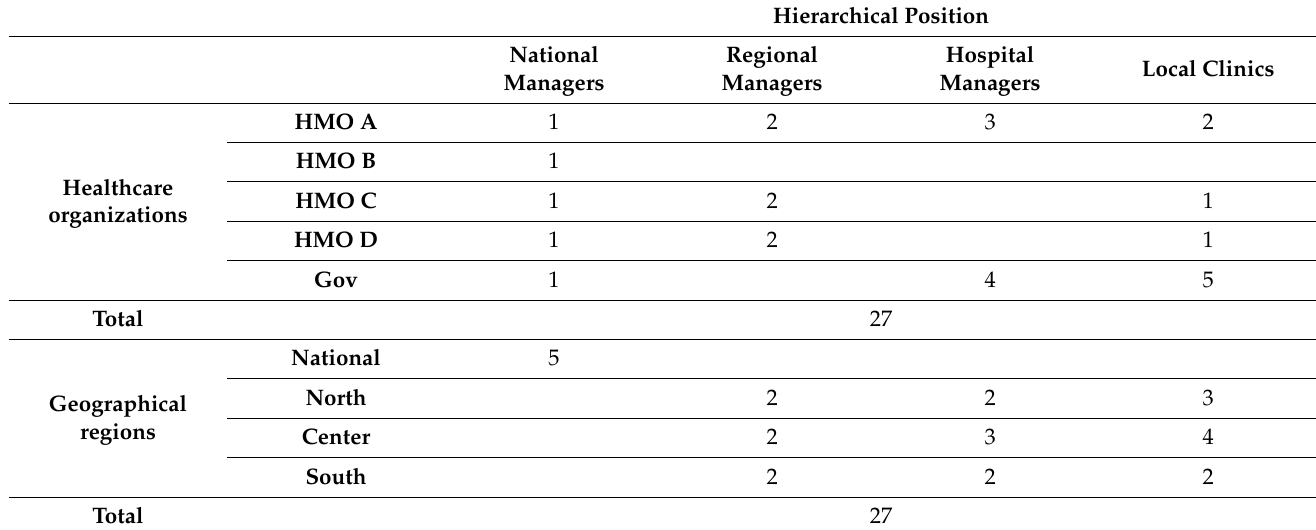
Table 1. Distribution of